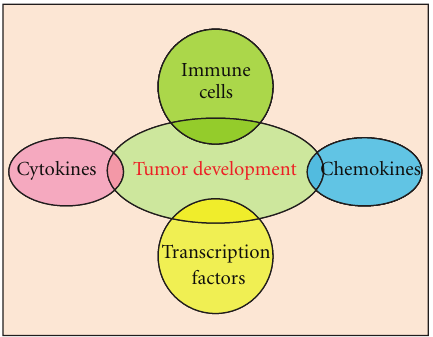
Figure 1: Major components of inflammatory microenvironment in bladder cancer.